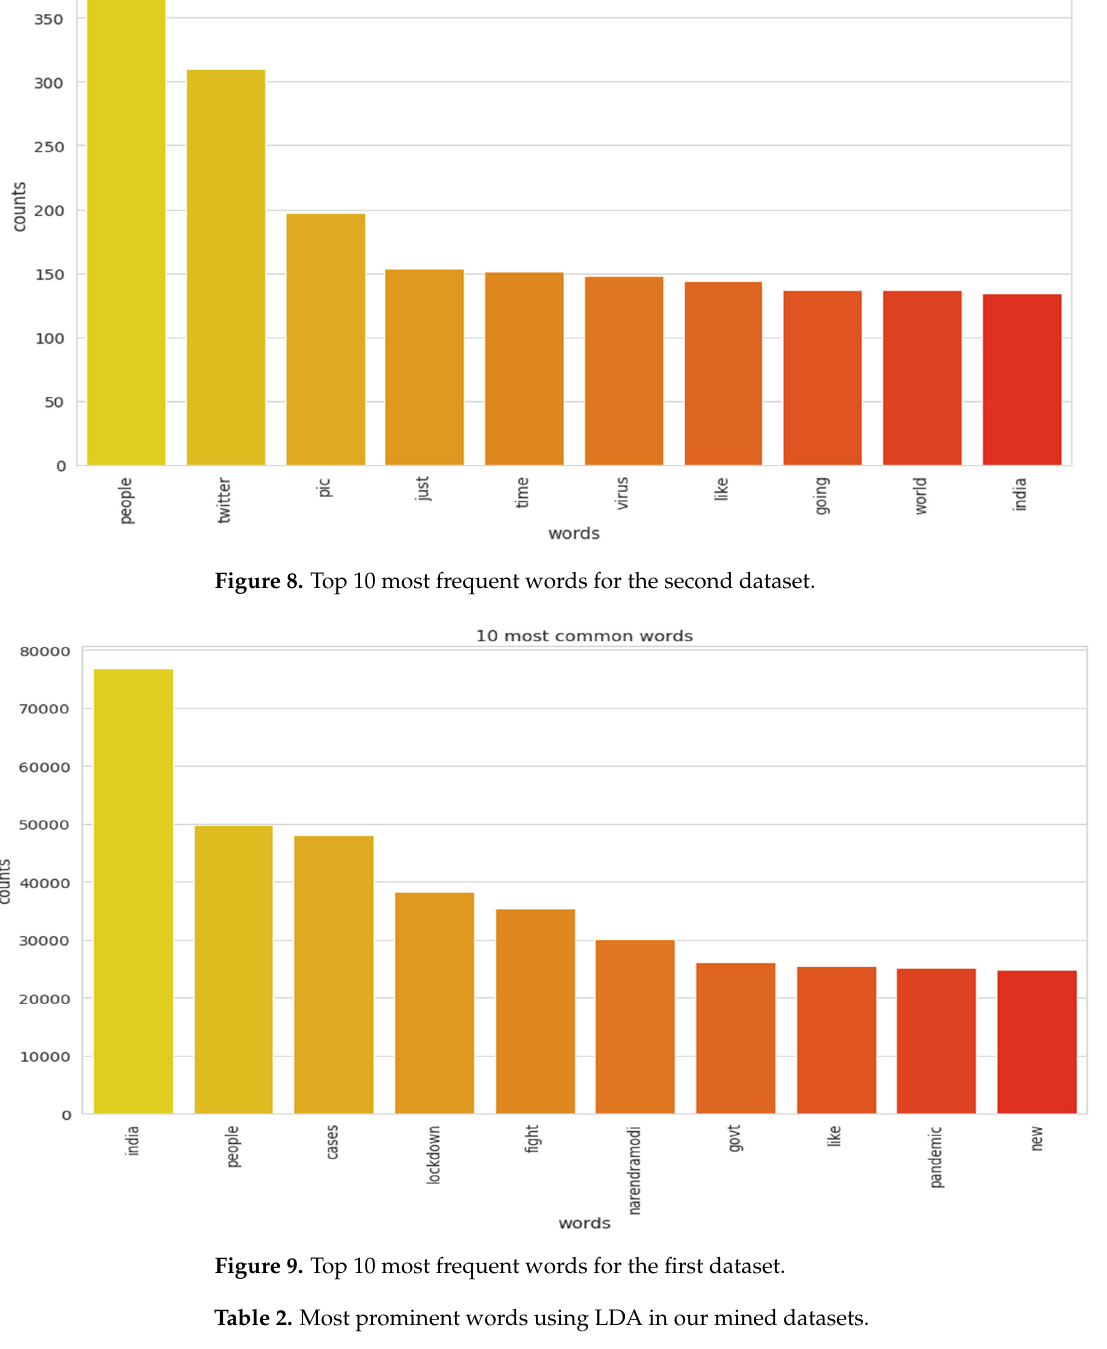
Figure 9. Top 10 most frequent words for the first dataset. Table 2. Most prominent words using LDA in our mined